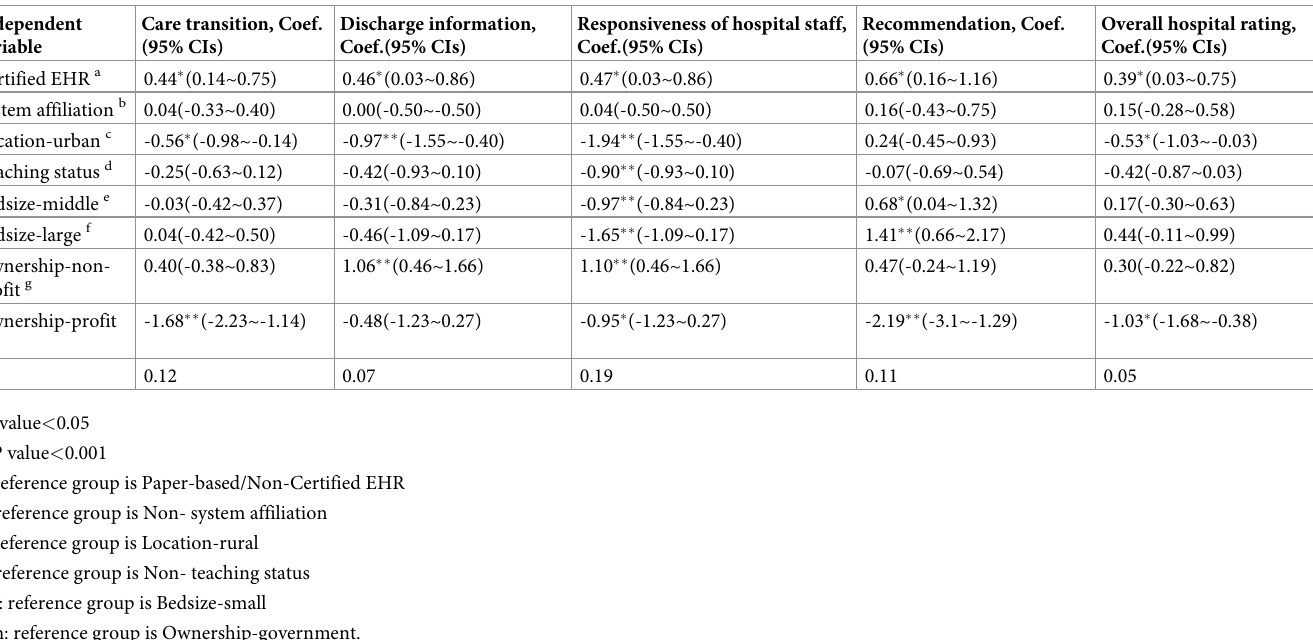
Table 3. Regression results of patient experience measures. Independent